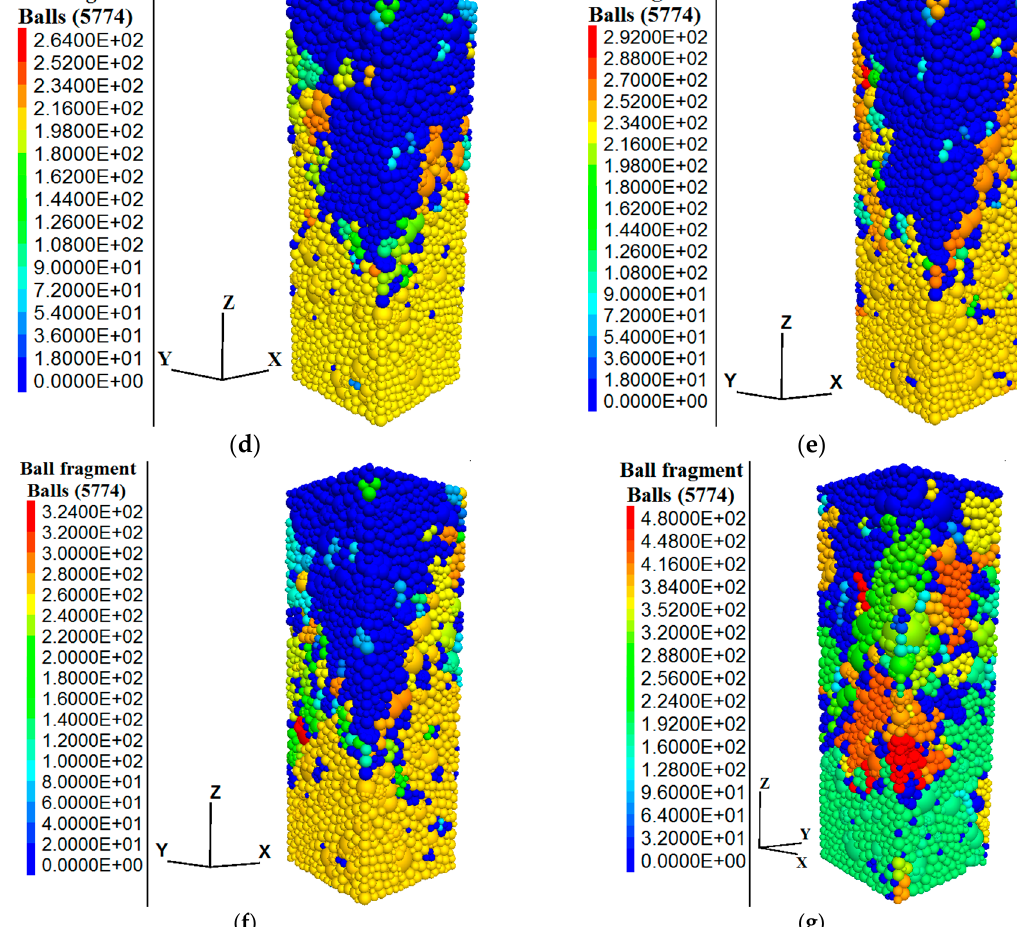
Figure 17. Failure states of concrete at the third stage point under different freezing–thawing cycles. ( a ) Failure state concrete without freeze–thaw; ( b ) Failure state of 25 freezing–thawing concrete; ( c ) Failure state of 50 freezing–thawing concrete; ( d ) Failure state of 75 freezing–thawing concrete; ( e ) Failure state of 100 freezing–thawing concrete; ( f ) Failure state of 125 freezing–thawing concrete; ( g ) Failure state of 150 freezing–thawing concrete.